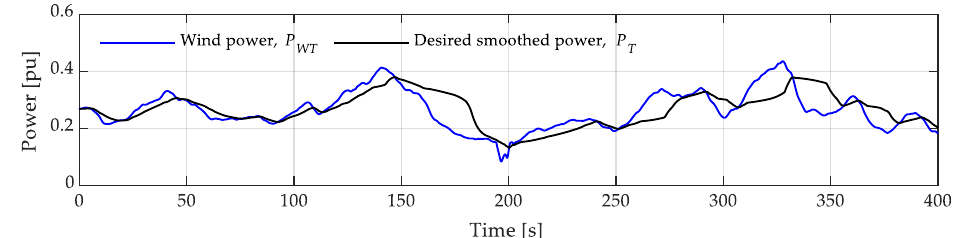
Figure 13. Wind power generated by the VSWT and the expected resulting power with the application of the proposed algorithm.